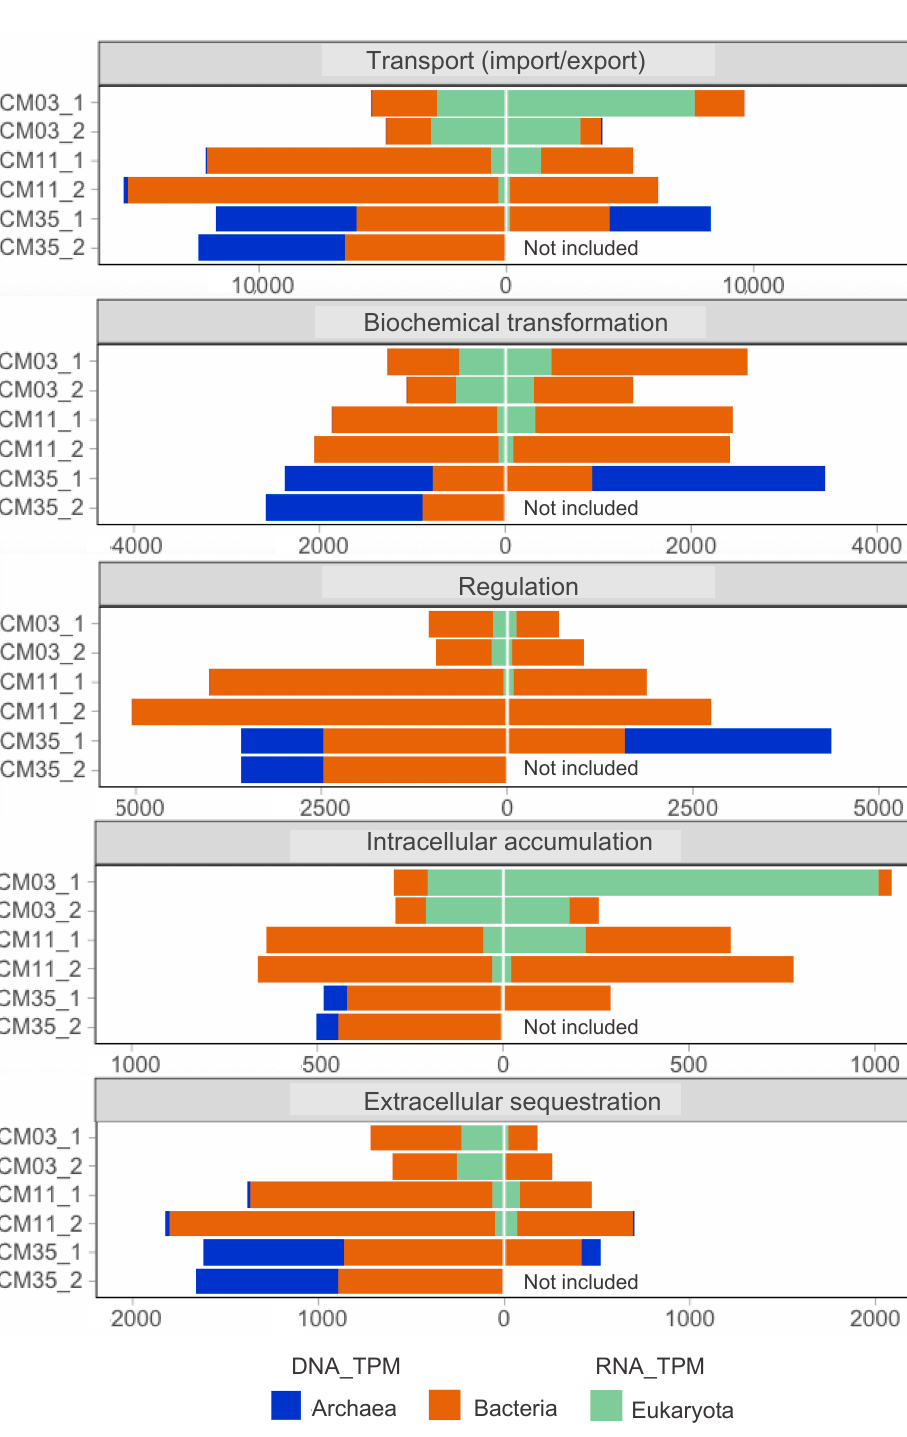
Figure 2. Gene profiles (left sides) and transcript profiles (right sides) of metal resistance response mechanisms detected in the three layers of Cueva de la Mora (CM) and mapped back to the domain level. Genes per metagenome were functionally annotated with KOFAMscan [50] and taxonomically annotated with Diamond + MEGAN [47,48] and GhostKOALA [49]. _1 and _2 refer to replicates (DNA or mRNA reads from each replicate mapped to co-assembled metagenomes). Gene and transcript abundances calculated as TPM values. List of KOs for each metal resistance mechanism provided in Table S4. mRNA reads from CM35_2 are not included due to low mapping rates to the respective co-assembled metagenome.